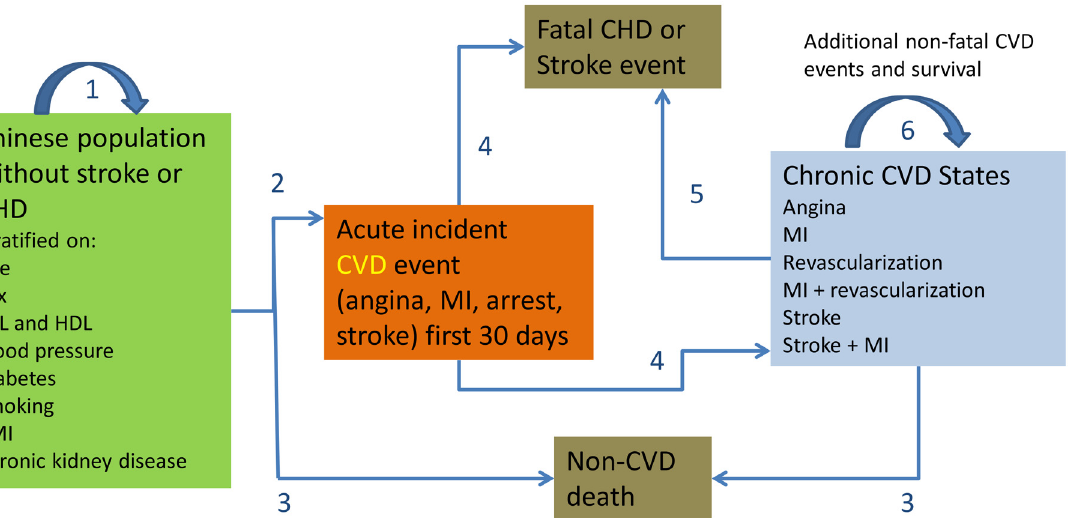
Fig 1. CVD Policy Model-China structure. State transitions are numbered in the diagram. Transition 1 = remain in CVD-free state. Transition 2 = incident CVD. Transition 3 = non-CVD death. Transitions 4 and 5 = survival or case fatality. Transition 6 = survival with or without repeat CVD event in chronic CVD